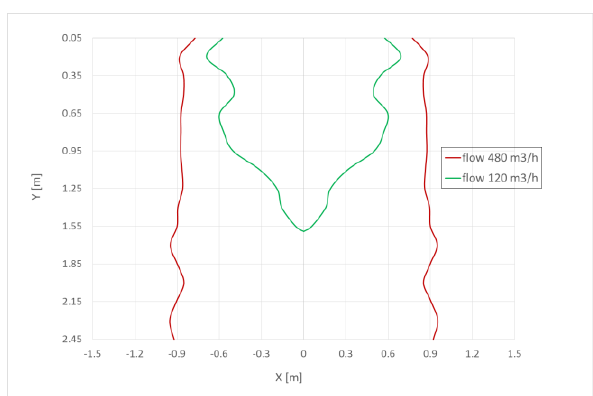
Fig. 12 . Range L0.2 of SLN diffuser flow, with downward flow, in the X-axis.